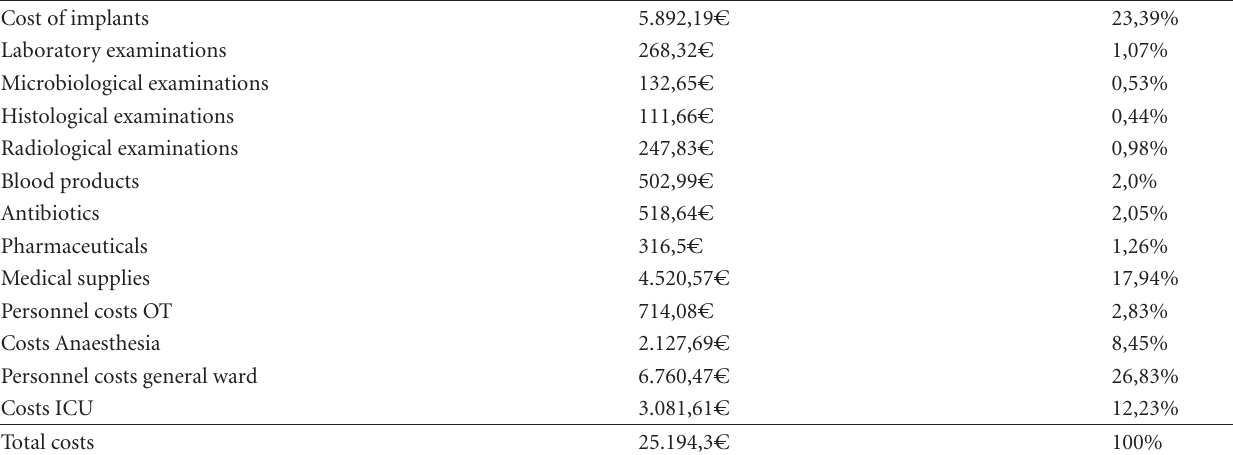
Table 1: Mean absolute und percentage costs of relevant positions in infected TKA.